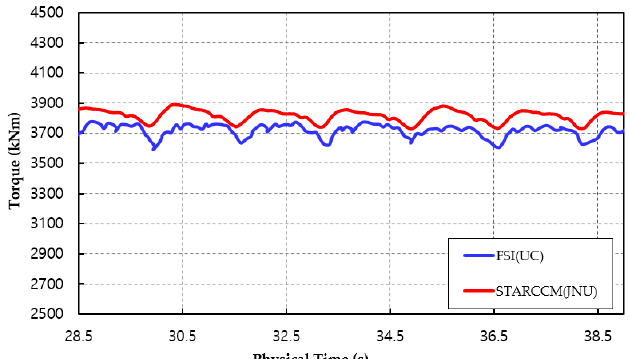
Figure 6. Onshore 5 MW wind turbine fluid domain and boundary conditions.